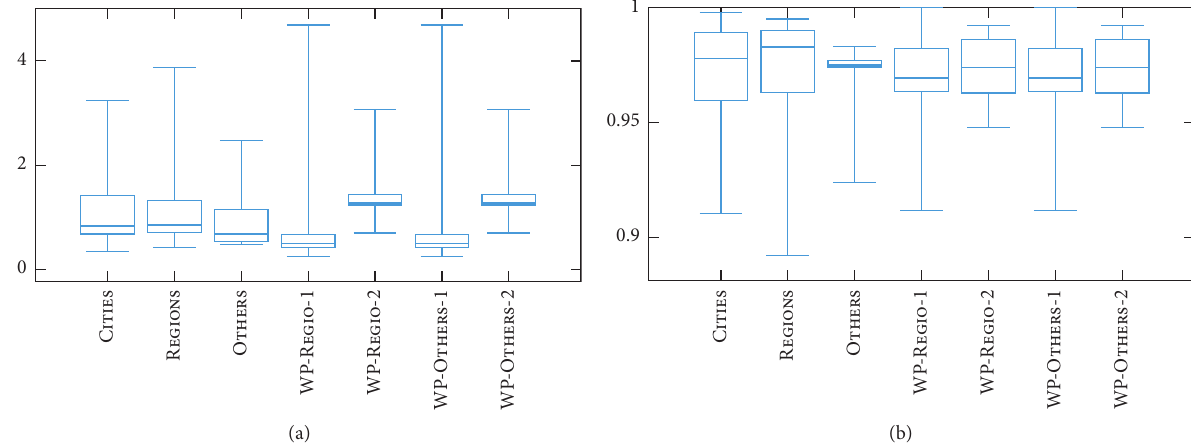
Figure 24: (a) Boxplots of the distribution of the exponents of the power laws fitted to the weight distributions of the nodes in the TTNs differentiated by the target classes. (b) The boxplots of the corresponding fitting accuracies computed by means of the adjusted R -squared.